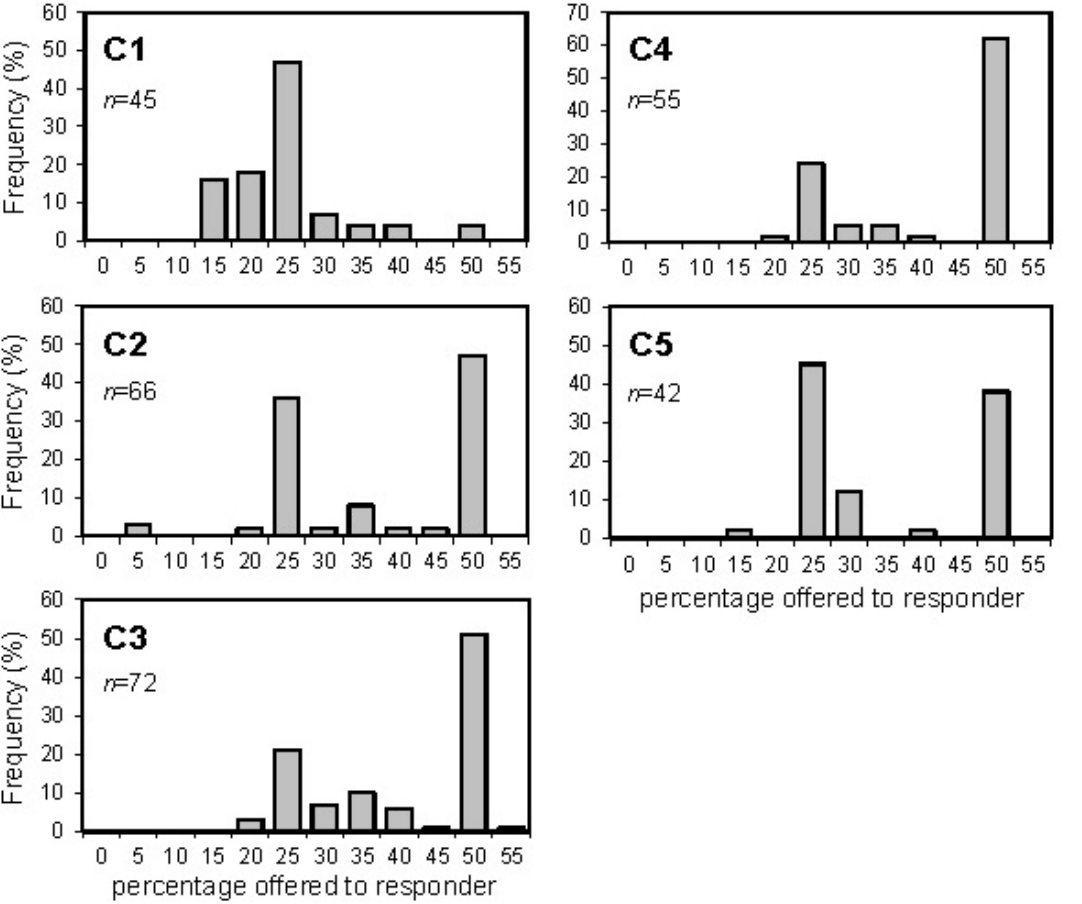
Fig. 5 . Offers given by Player 1, the proposer, in the Ultimatum Game. Histograms show frequency of offers of varying amounts; the distribution of offers is used as an indicator of norms of fairness in a community. Offers by C1 players exhibit a unimodal distribution, with the mode offer being 25% of the stake; whereas offers from other communities were bimodally distributed, around modes at 25% and 50% of the stake. Sample size in each community indicated on